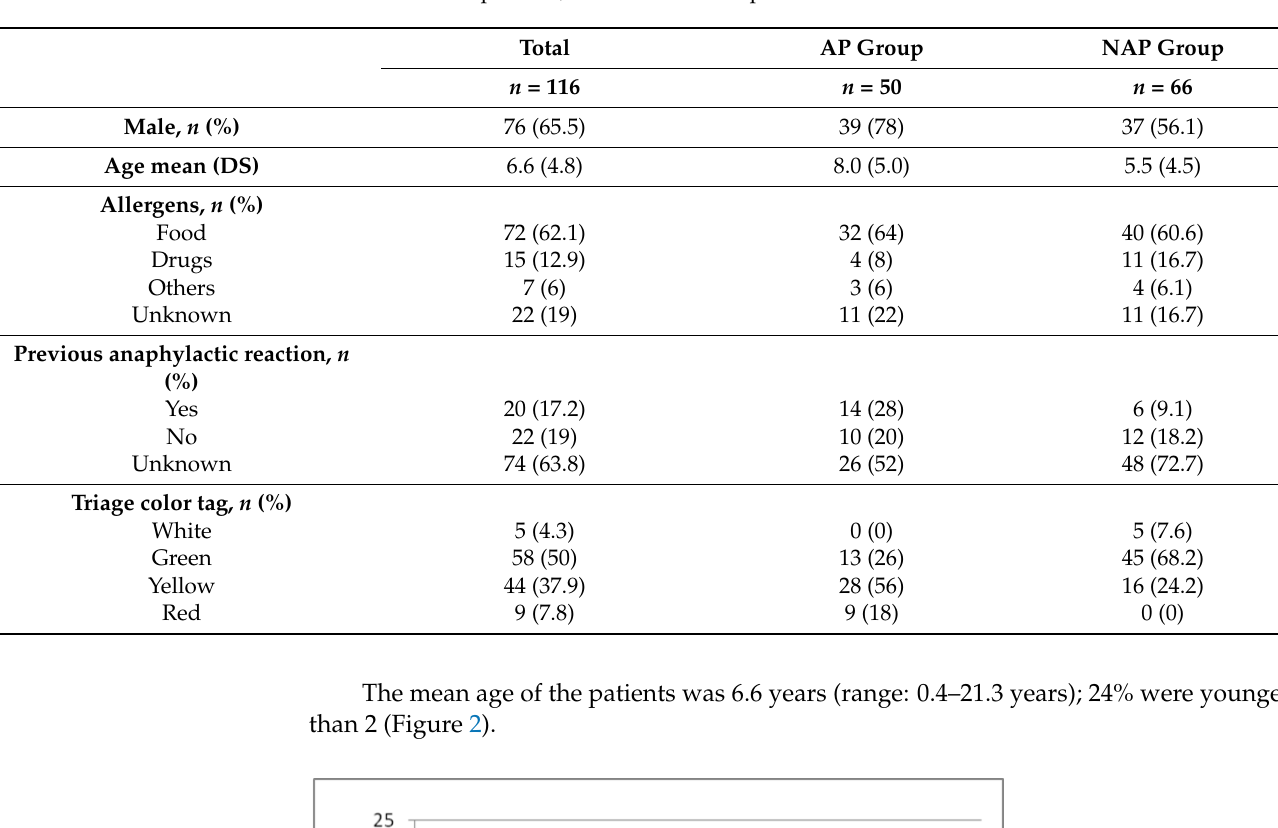
Table 2. Demographic and clinical characteristics of 116 children presenting to the PED for anaphylaxis. AP = acute patients, NAP = non-acute patients.